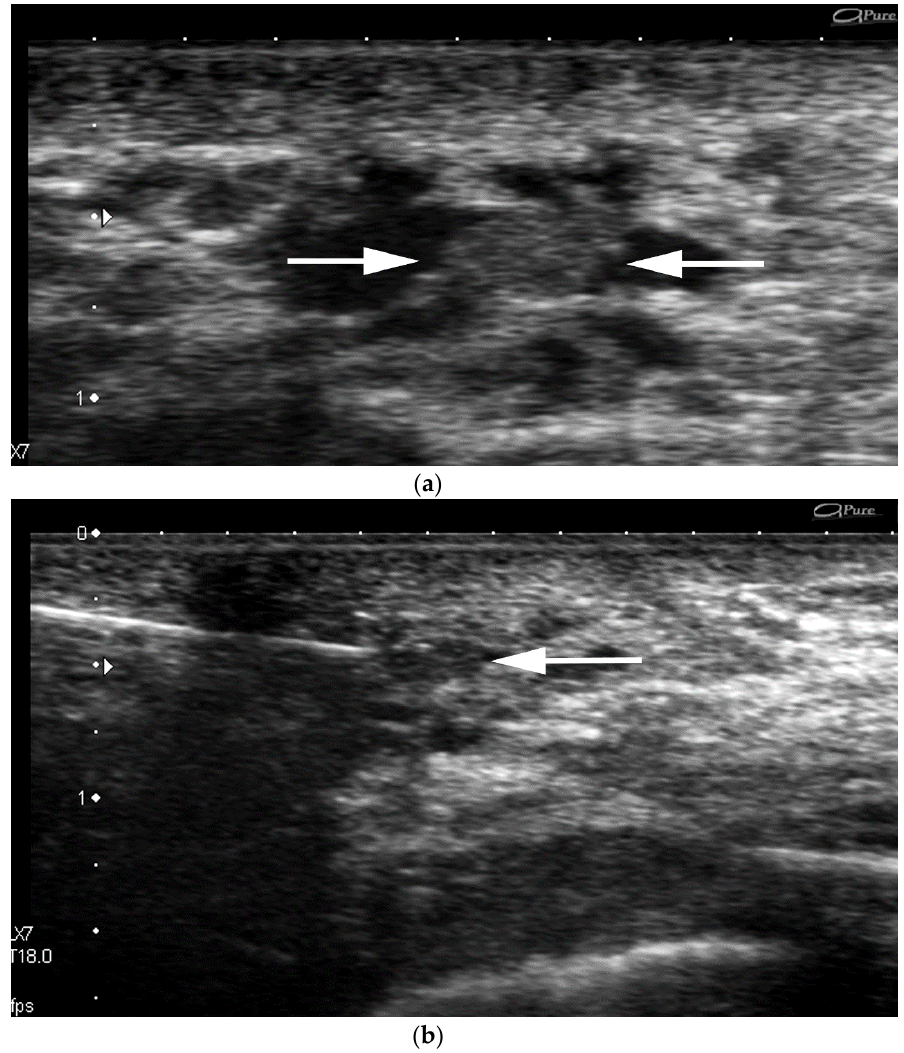
Figure 5. US-guided procedures images of a retroareolar lesion. Evidence of a new retroareolar microlobulated isoechoic mass measuring 4 mm within a dilated duct in a 57 year-old patient ( a ) (arrows). The intraductal lesion becomes less visible after freezing ( b ) (arrow). US-guided per procedure image of the same structure. The lesion is no longer visualized after one pass. Pathology yielded papilloma.